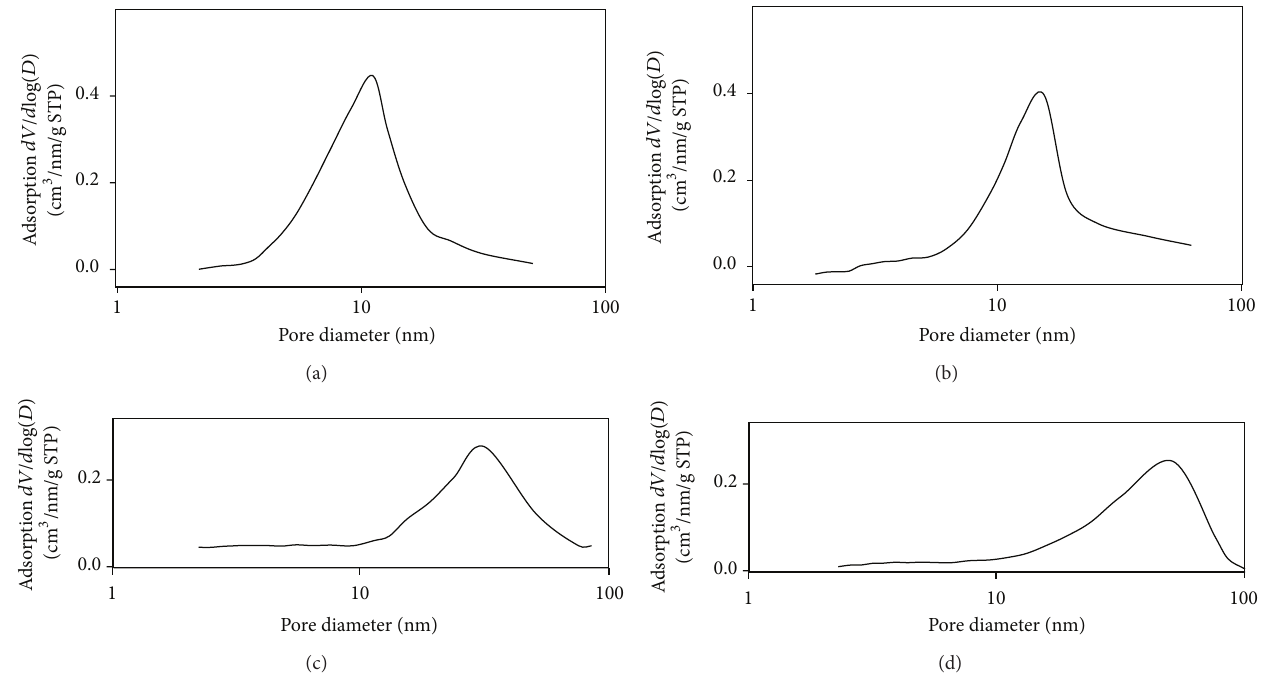
Figure 3: Adsorption BJH pore size distribution of prepared catalysts after calcinations ((a) HLB = 13.9, (b) HLB = 23.7, (c) HLB = 31.2, and (d) HLB =